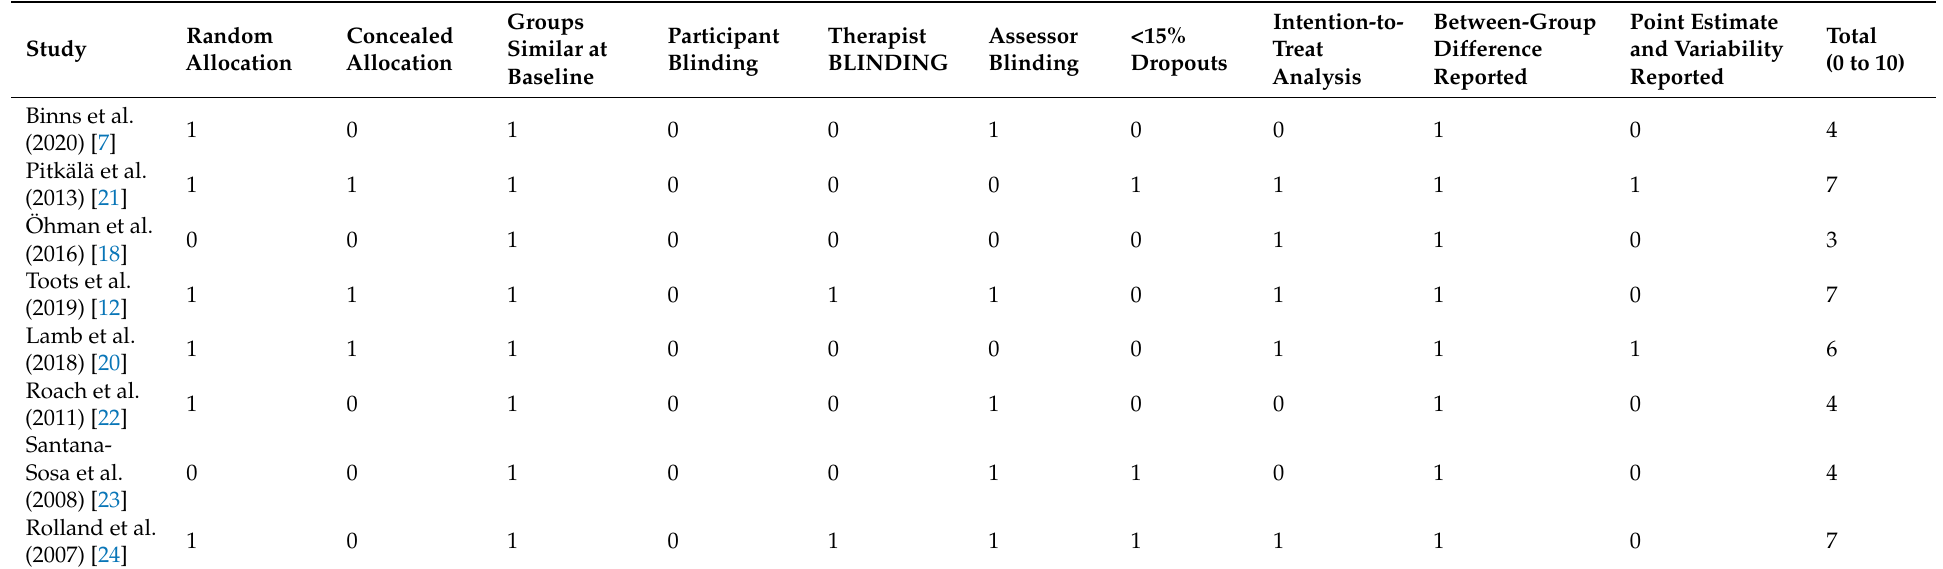
Table 1. PEDro scores of included